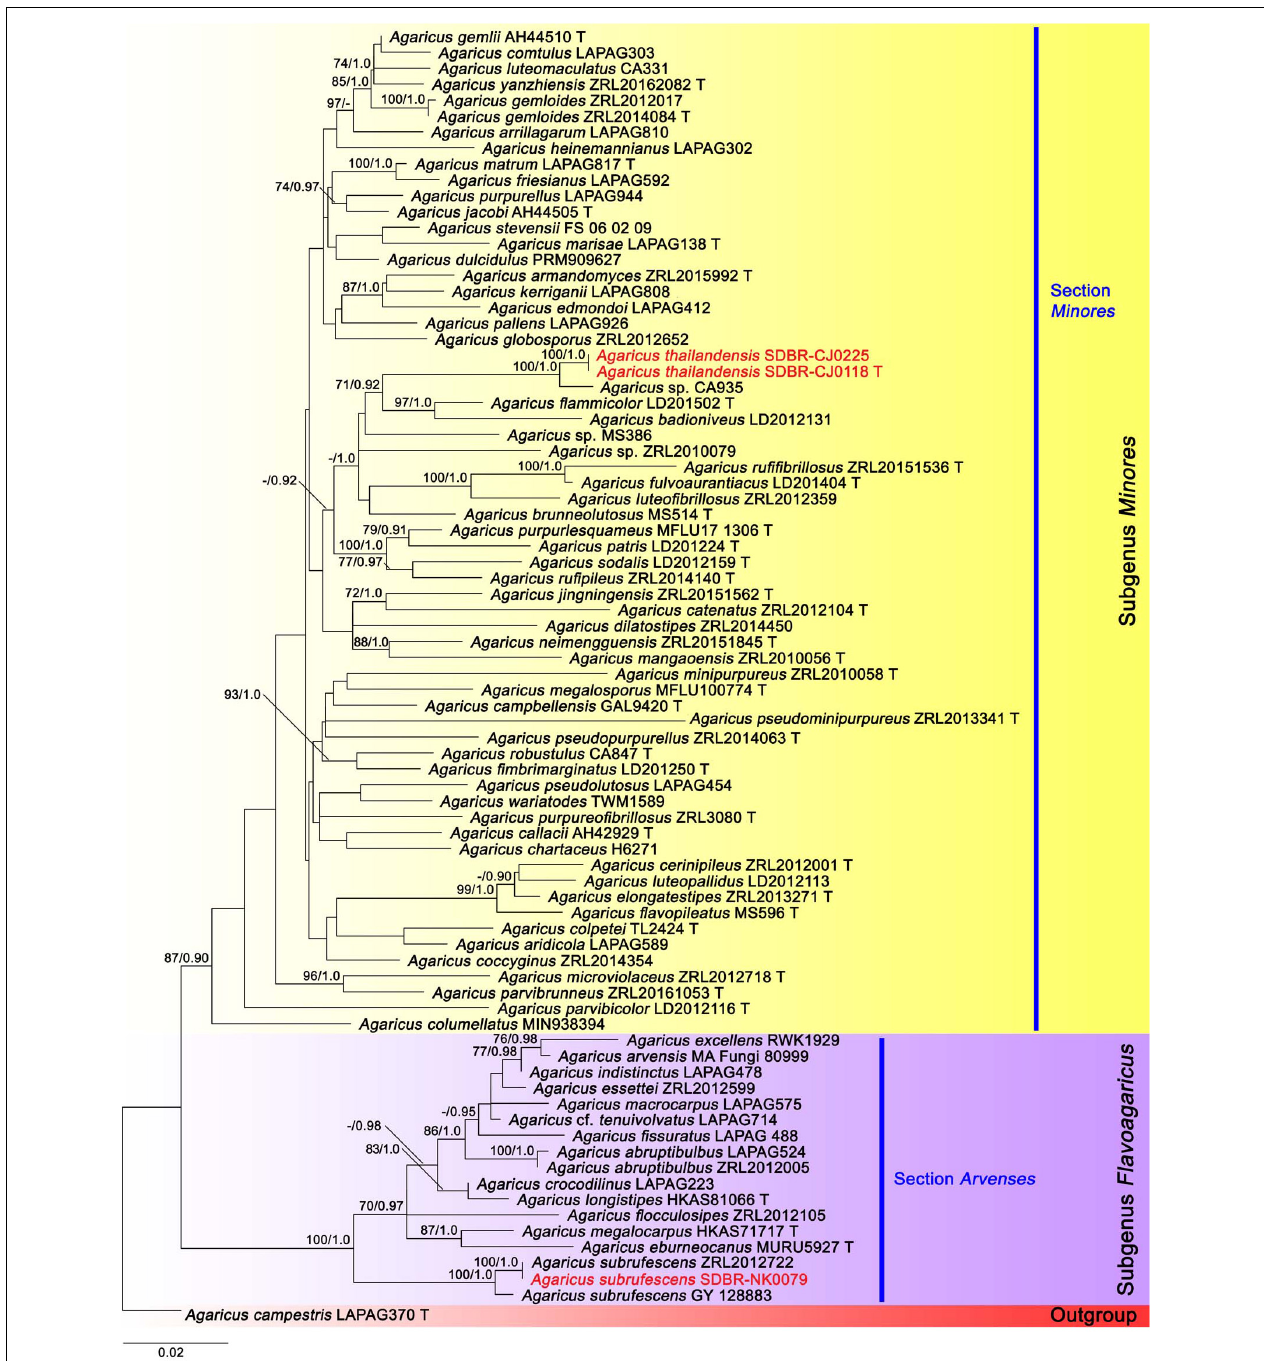
FIGURE 1 | Phylogenetic tree of the genus Agaricus generated from maximum likelihood based on multigene sequences (ITS, LSU, tef 1 exons, and tef 1 introns) of Agaricus subg. Flavoagaricus and Agaricus subg. Minores . Agaricus campestris was used as an outgroup. The vouchers from this study are in red and “T” means type specimen. Bootstrap support values (BS ≥ 70%) and posterior probabilities (PP ≥ 0.90) are presented above the supported branches.